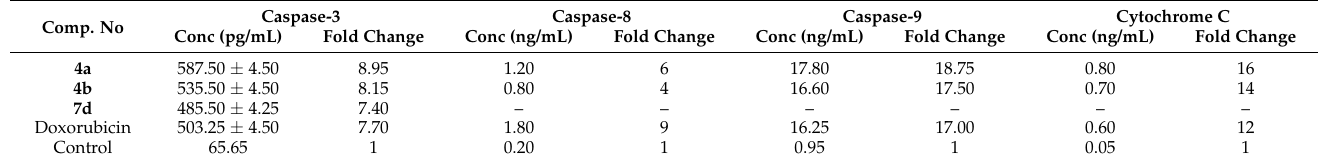
Table 4. Effect of compounds 4a , 4b , and 7d on caspases 3, 8, 9 and Cytochrome